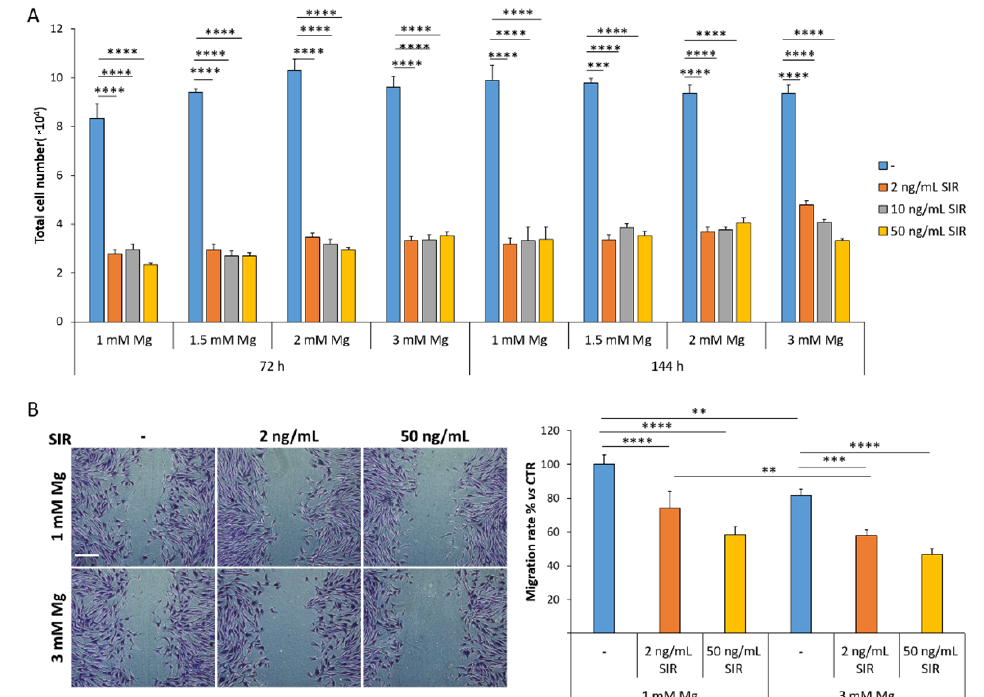
Figure 4. The effects of sirolimus and Mg on rSMC. ( A ) The cells were counted after 72 and 144 h of culture in medium containing 1, 1.5, 2 or 3 mM Mg with or without different concentrations of sirolimus (2, 10, 50 ng/mL). ( B ) Confluent rSMC were cultured in the presence of 1 or 3 mM Mg combined with 2 or 50 ng/mL of sirolimus for 72 h and the wound assay was performed. 24 h later, the width of the wound was visualized and measured. Representative images of the scratches are shown (left panel). Scale bar: 125 µ m. The migration rate was analyzed using ImageJ and data are shown as the percentage of migration compared to the control (CTR, 1 mM Mg without sirolimus, right panel). Data are expressed as the mean ± standard deviation of three independent assays (* p ≤ 0.05; ** p ≤ 0.01; *** p ≤ 0.001; **** p ≤ 0.0001).